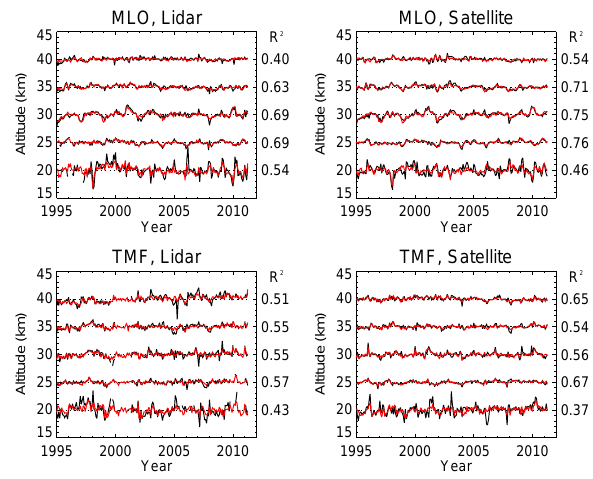
Fig. 3. Time-series of ozone anomalies (black) at 5km intervals and their corresponding regression fitting results (red) at MLO and TMF for both datasets. The ozone perturbation scale is 10%km − 1 . The numbers in front of each dashed line denote the R 2 coefficient given by the fit